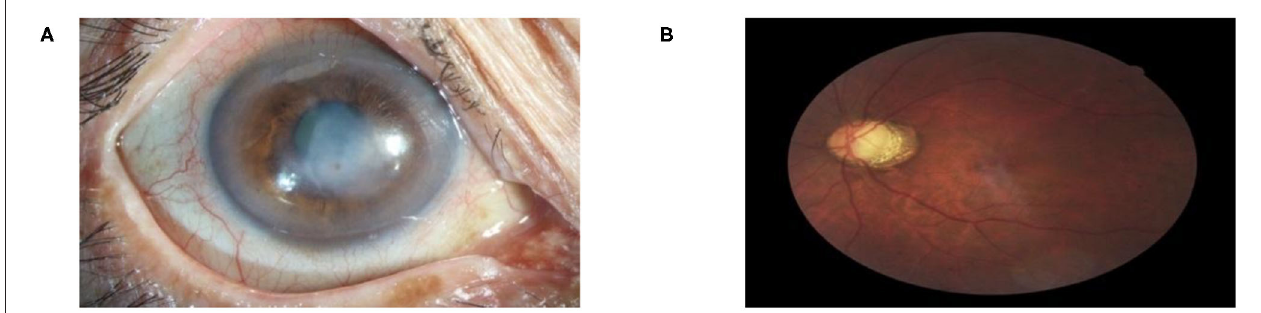
FIGURE 5 | Multi-label diagnostic results. The proposed hierarchical deep learning framework is capable of detecting multiple diseases simultaneously on the same patient: (A) cataract with 76.74% and corneal disease with 75.94% confidence and (B) glaucoma with 79.04% and retinopathy with 51.01% confidence.